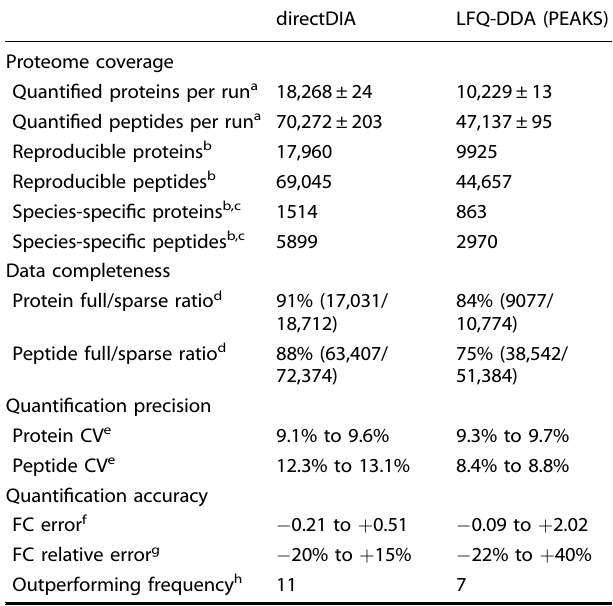
Table 1. Performance comparison of directDIA and LFQ-DDA on the spike-in metaproteome